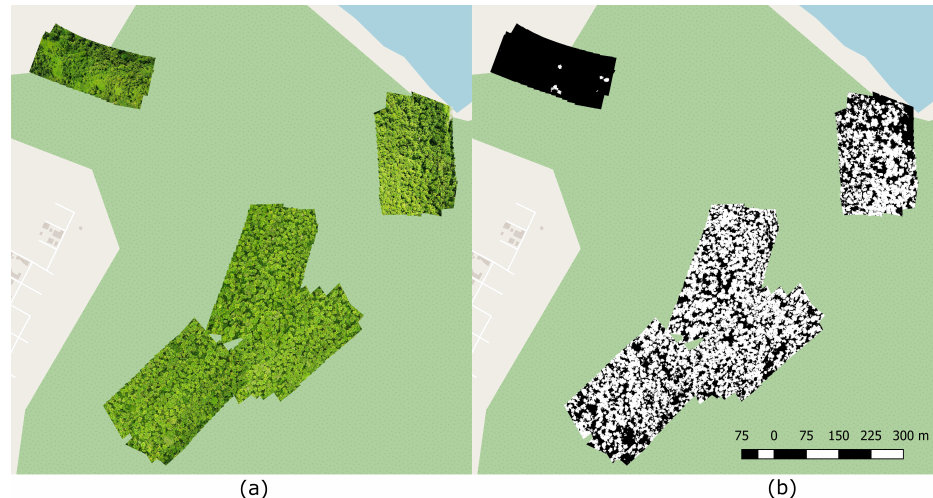
Figure 13. Aerial image mosaics acquired near Lake Quistococha. ( a ) Mosaics of RGB images. ( b ) Mosaics of Mauritia flexuosa